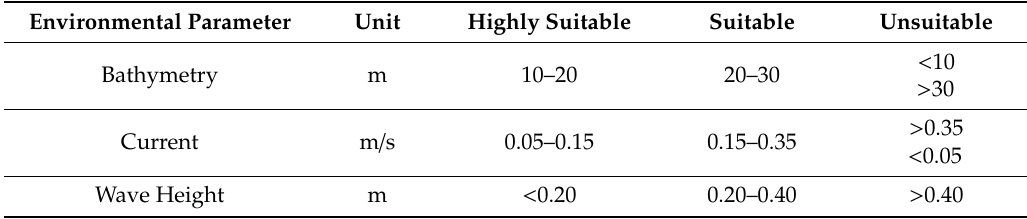
Table 3. Environmental parameters for